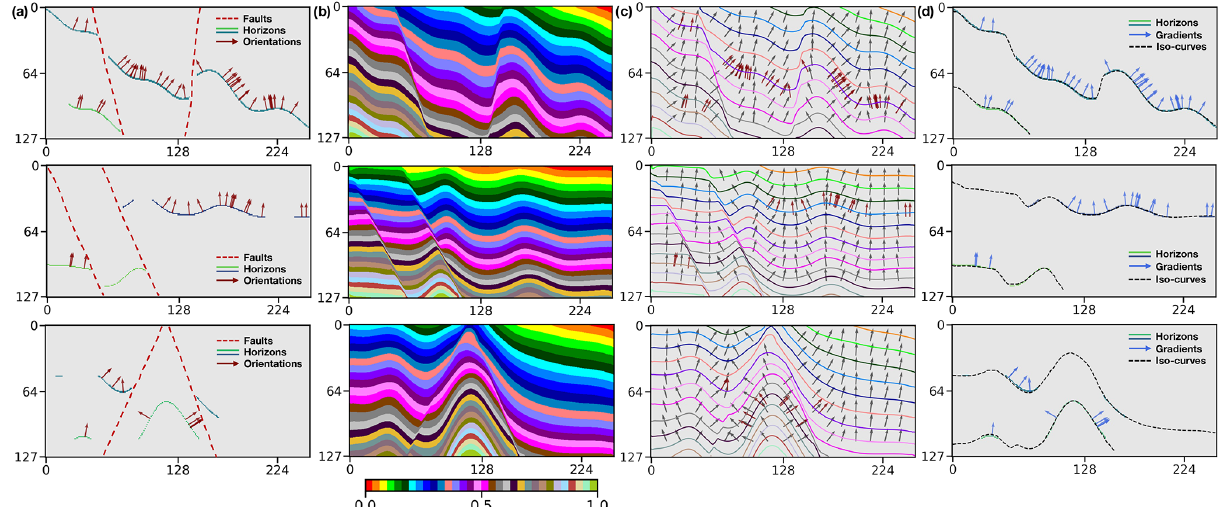
Figure 14. The faults and incomplete horizons, together with the structural orientations, are used as inputs (a) into the network to predict structural models (b) . The sets of regularly spaced iso-lines and local orientations are obtained from the modeling results (c) and compared with the given normal vectors (red arrows). The modeled stratigraphic interfaces and their normal vectors match the two distinct input horizons well (d)